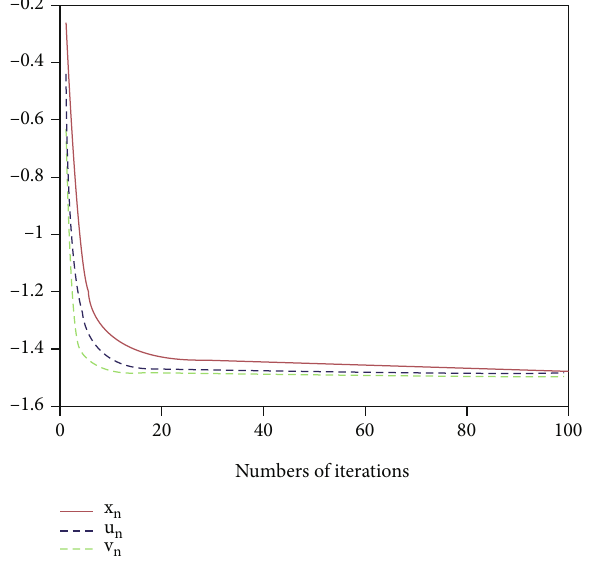
Figure 2: Convergence of iterative sequences f u to z = − 1 : 5 for β